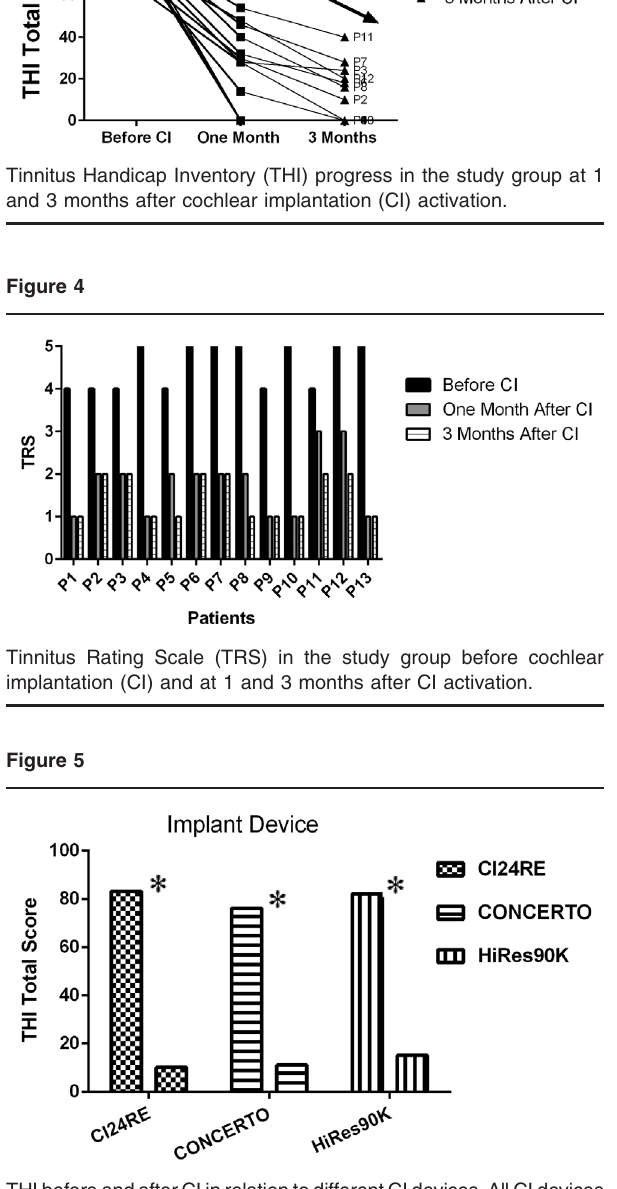
THI before andafterCI in relation to different CI devices. All CI devices (CI24RE, Concerto, and HiRes90K) elicited a significant reduction in tinnituslevelsinimplantedpatients(* P < 0.05;analysisofvariancetest). CI, cochlear implant; THI, Tinnitus Handicap